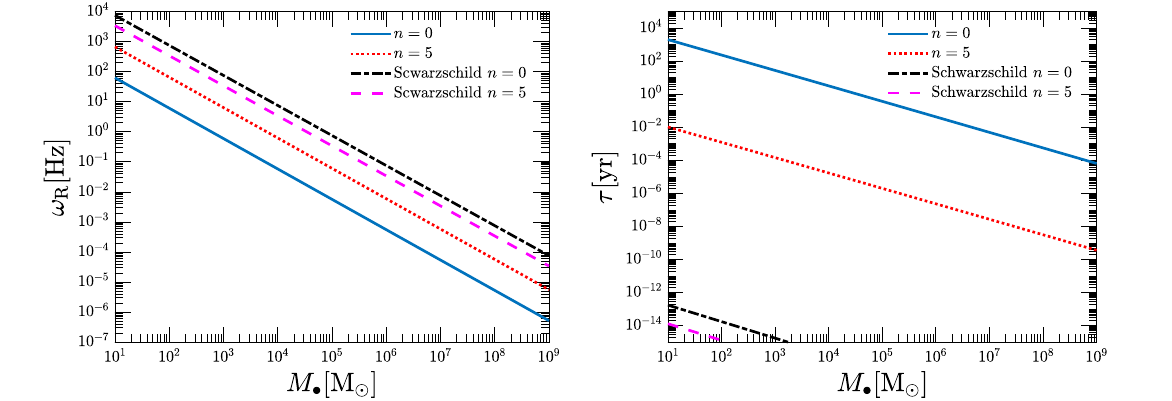
Fig. 5 The frequency (left panel) and damping period (right panel) of the quasinormal modes n = 0, n = 5 for (cid:14) = 2 of the cosmological black hole with respect to its mass M • . These apply to all solutions { K = 1 , N = 3 } , { K = 2 , N = 5 } depicted in Fig. 1, since any differ-